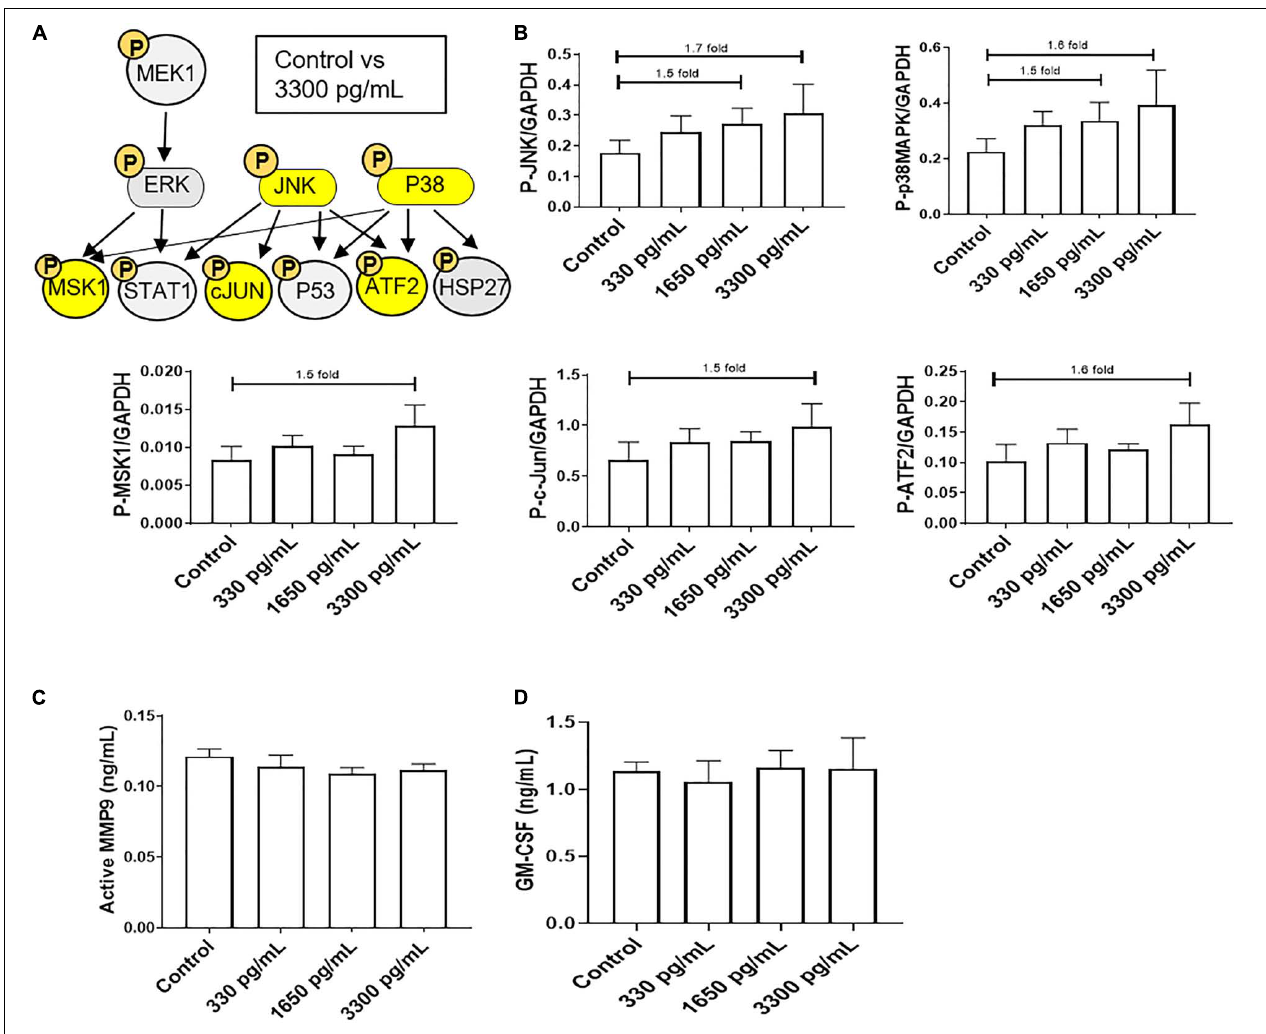
FIGURE 1 | IL-6 dose reported in term labor amniotic fluid activates JNK and p38MAPK, leading to downstream kinase activation in AECs. (A) Schematic of various phosphorylated (P) kinases tested using a multiplex immunoassay. Highlighted (yellow) P-proteins were upregulated, though not significantly, after IL-6 treatment mimicking term labor (3,300 pg/mL) compared to control-treated AECs. (B) IL-6 treatment (3,300 pg/mL) of AECs showed increasing trends of upstream kinases activation, JNK (1.7-fold) and p38MAPK (1.6-fold), which contributed to the downstream activation of MSK1 (1.5-fold), c-JUN (1.5-fold), and ATF2 (1.5-fold) compared to control samples. N = 5; mean ± SEM medium florescent intensity. (C,D) IL-6 did not increase the inflammatory profile of AECs, as seen by no changes in MMP9 activation or GM-CSF production when compared to control or term labor IL-6 treatment (3,300 pg/mL). N = 5; mean ±